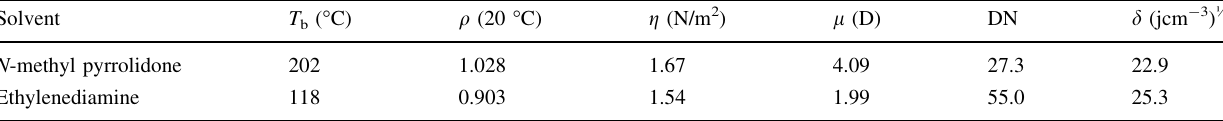
Table 2 Properties of the two main solvents, NMP and EDA Solvent